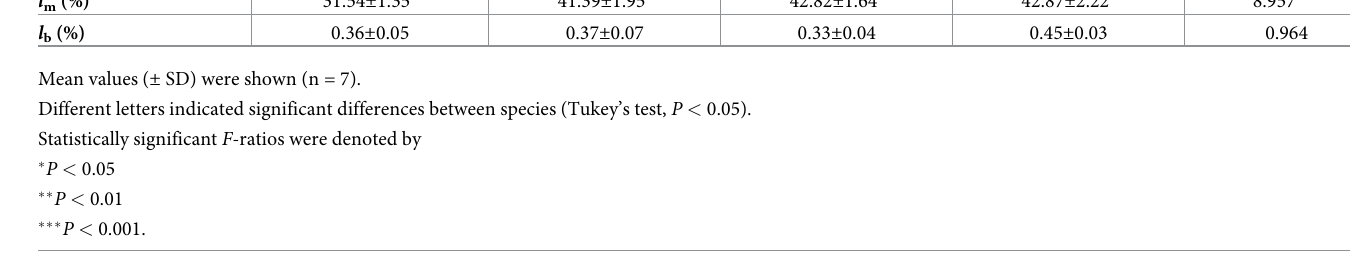
Table 2. Relative stomatal ( l s ), mesophyll ( l m ) and biochemical ( l b ) photosynthesis limitations in four species seedling leaves. Leaf traits